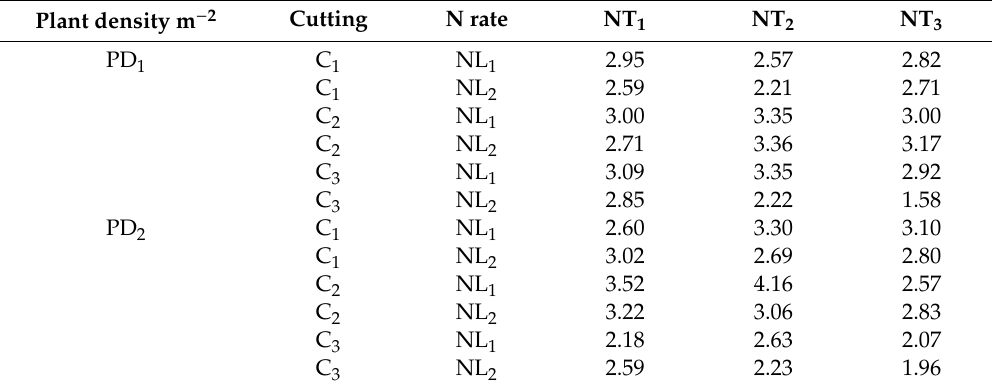
Table 10. The interactive e ff ects of di ff erent factors over economic benefits (VCR